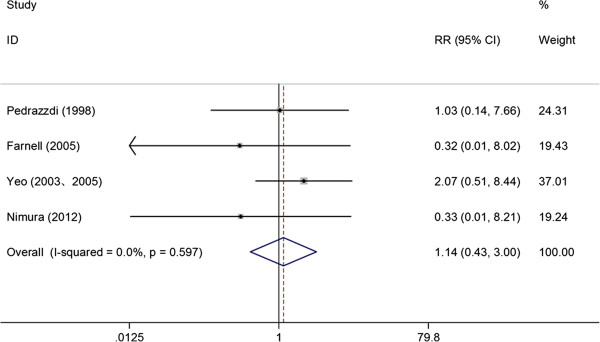
Forest plot for the postoperative mortality between the pancreatoduodenectomy with extended lymphadenectomy (PD/ELND) group and the standard pancreatoduodenectomy (PD) group. The size of the black box corresponding to each study is proportional to the sample size, and the horizontal line shows the corresponding 95% CI of the relative risk (RR) displayed on the right.